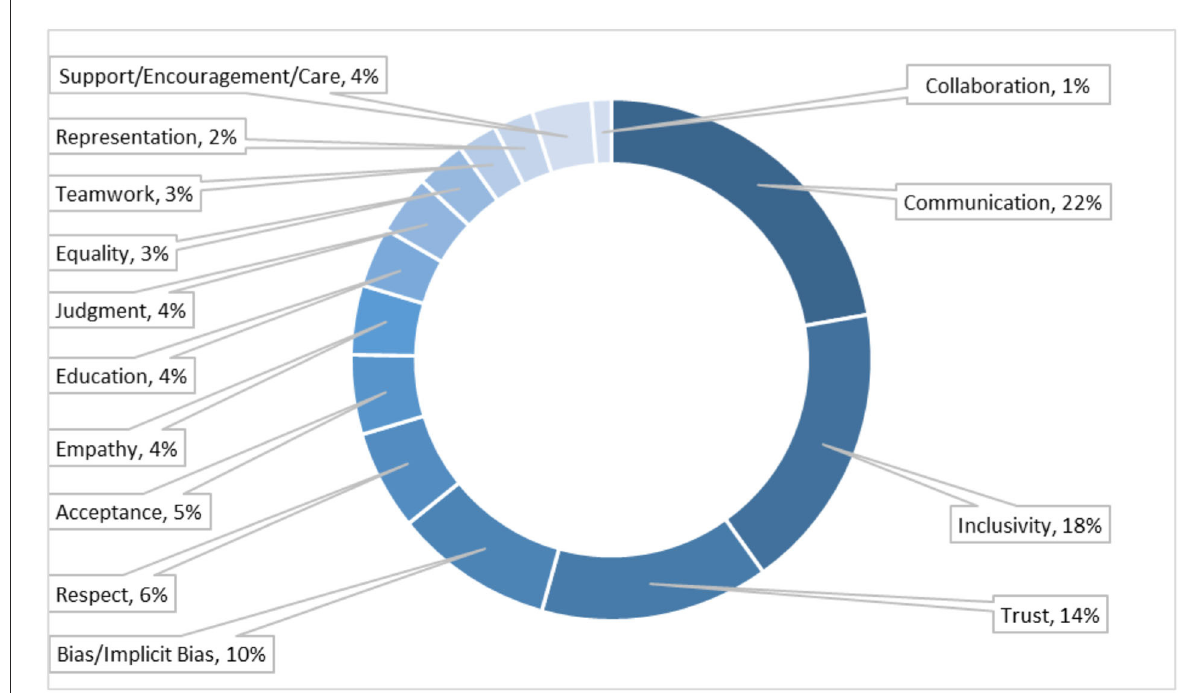
FIGURE4 Key themes established through the session. Representation of common qualitative responses of the post-activity survey ( n = 162, input responses) to the following prompt: P11: List any three Key Words/Phrases which come to your mind after this IPE activity?